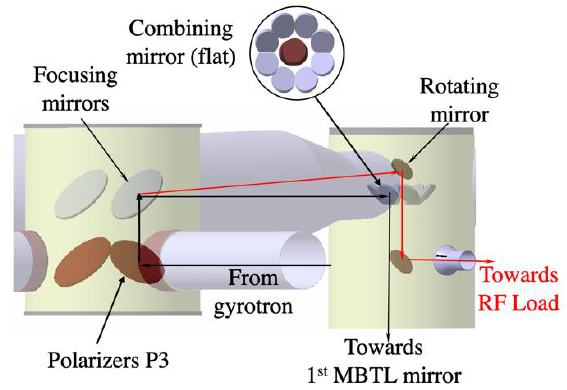
Fig. 5. Detail of the connection between SBTL and RF load. The beam coming from the gyrotron can be tilted by a focusing mirror to reach, on top in the centre of the combining mirror, the rotating plane mirror. This mirror is designed to redirect the beam vertically down where the fixed mirror reshapes the beam and directs it into the load (red arrow).